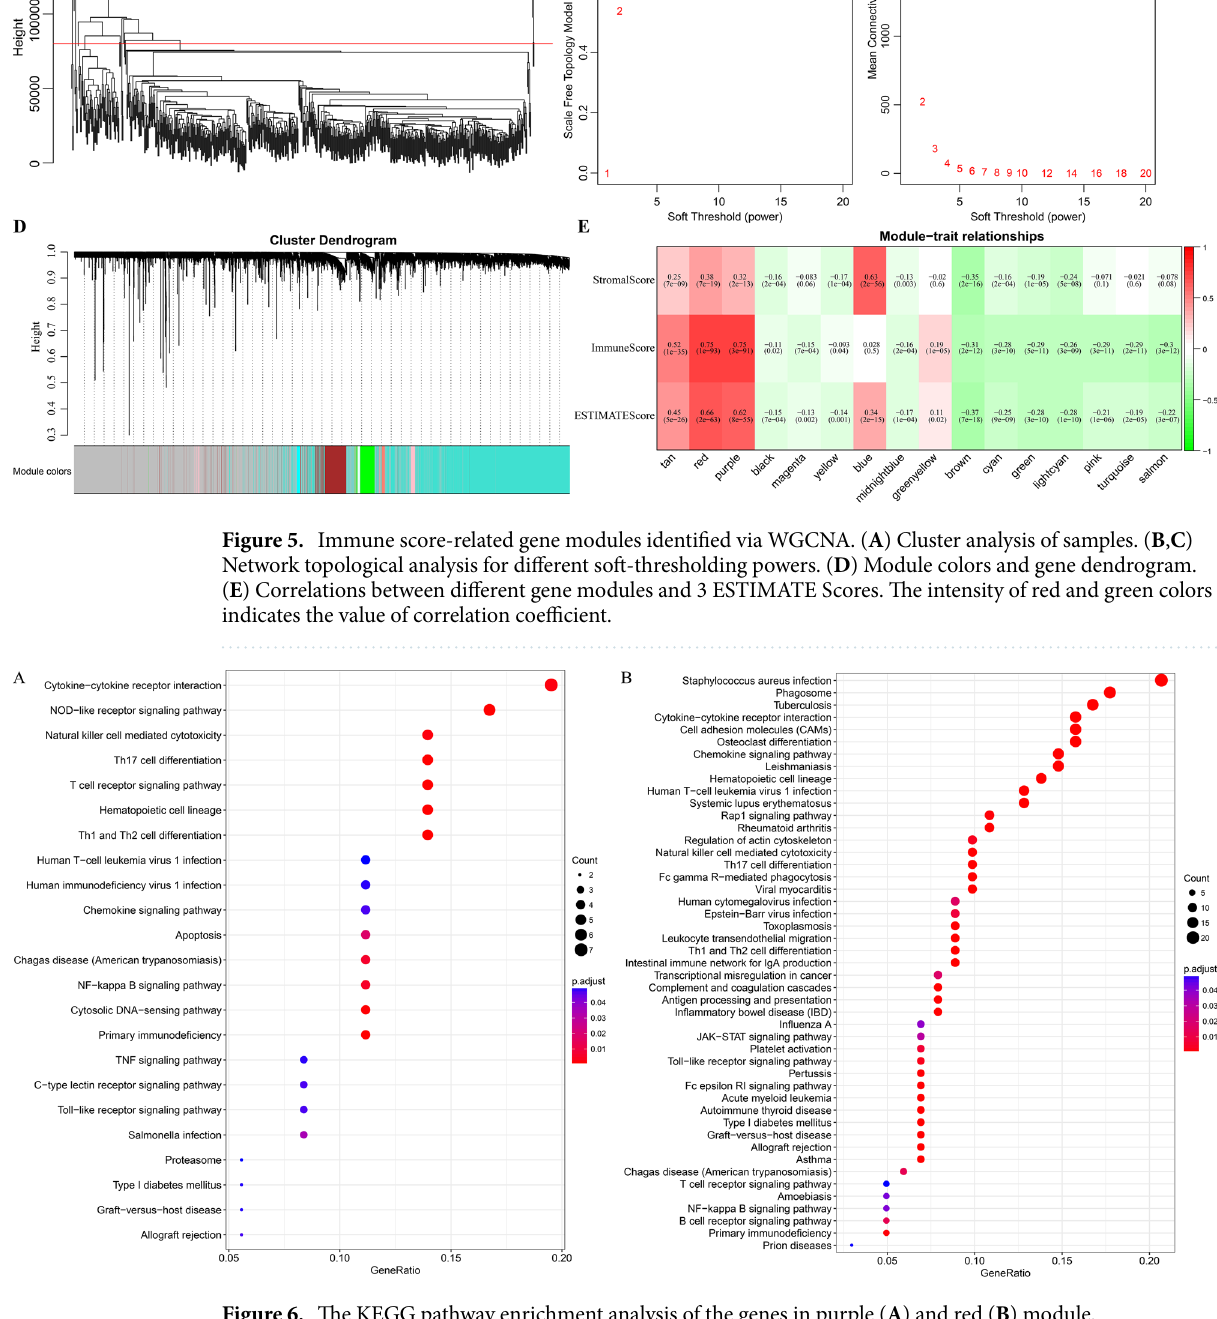
Figure 6. The KEGG pathway enrichment analysis of the genes in purple ( A ) and red ( B )